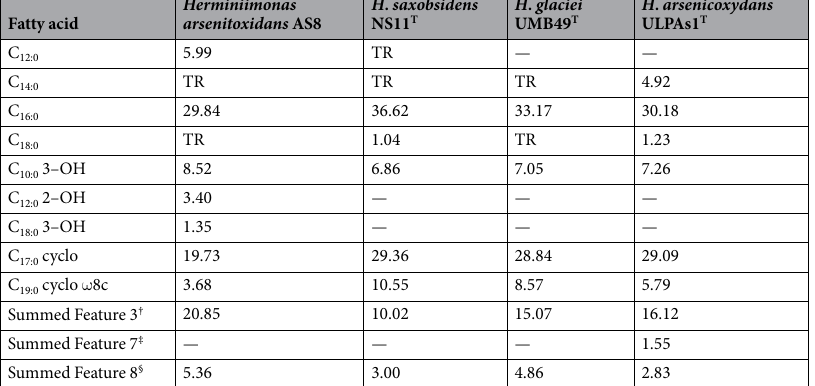
3 Scientific REPoRTS | 7: 15007 | DOI:10.1038/s41598-017-15164-4